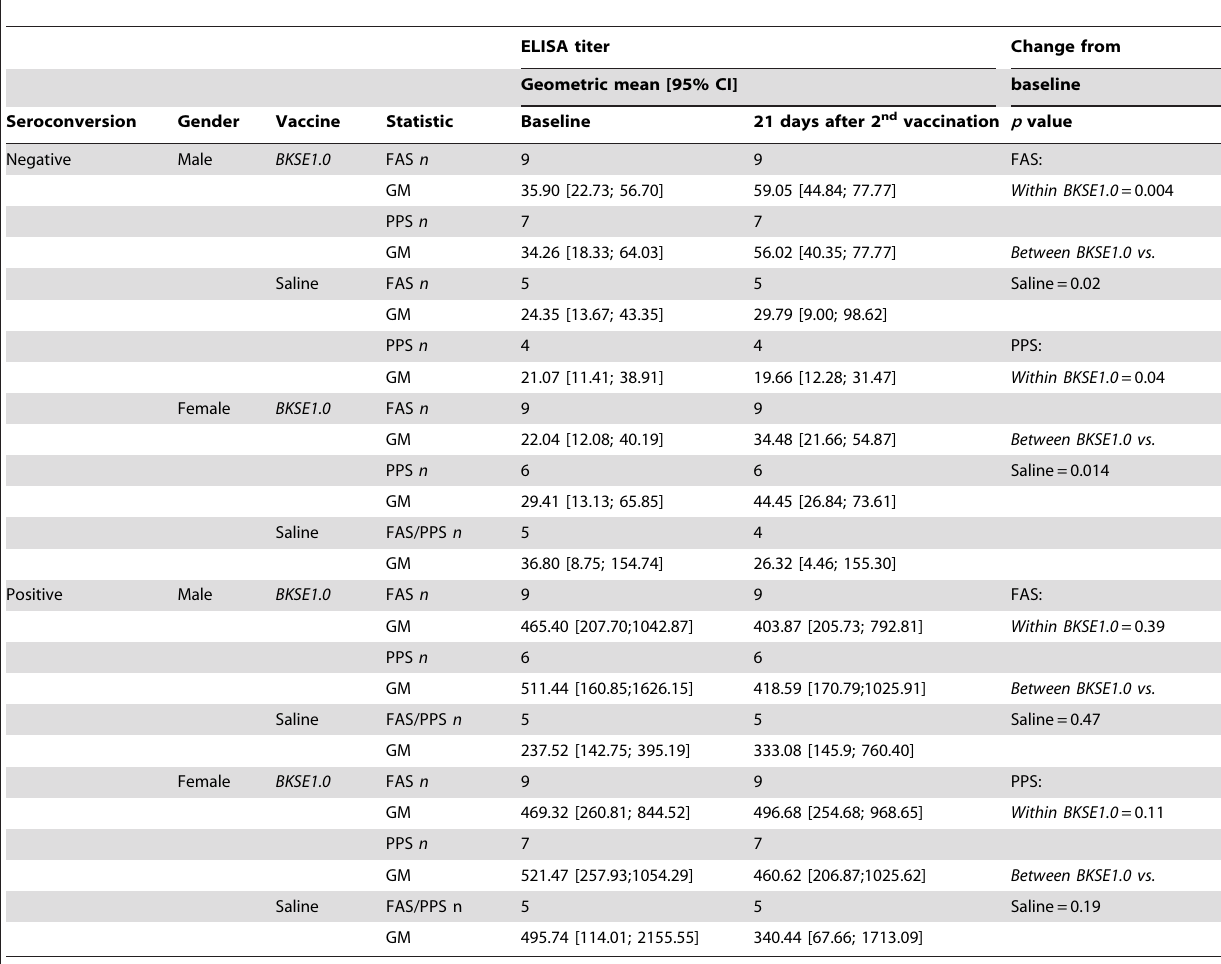
Table 4. Anti-SE36 antibody titers pre-vaccination (baseline) and 21 days post-second vaccination in Stage1.